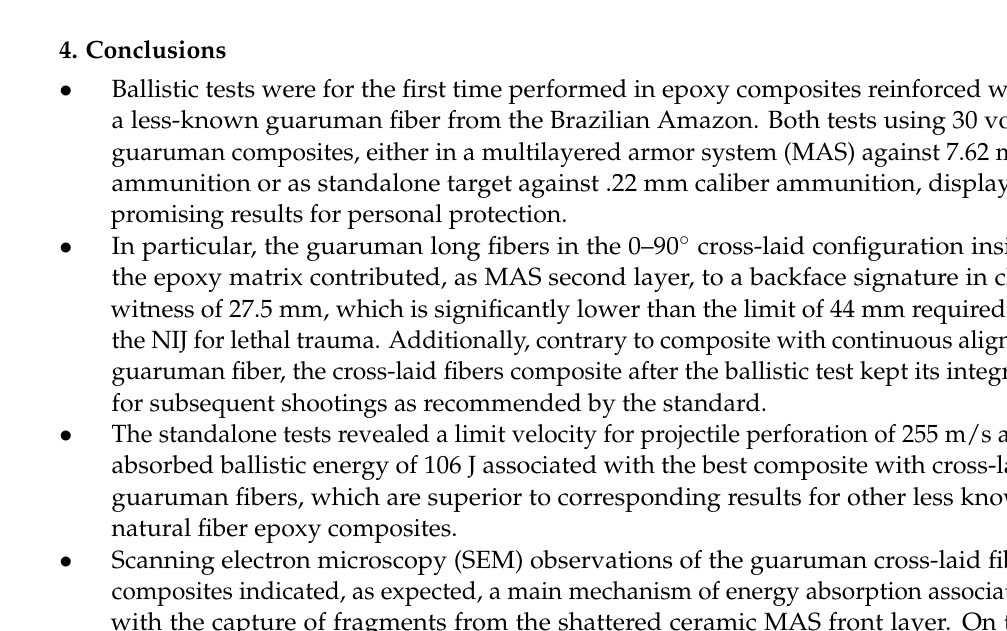
Figure 10. SEM fractograph of the epoxy composite with 30 vol% guaruman cross-laid fibers after standalone ballistic